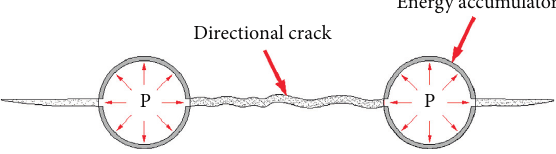
Figure 6: Directional blasting model. Table 1: Explosive parameters.